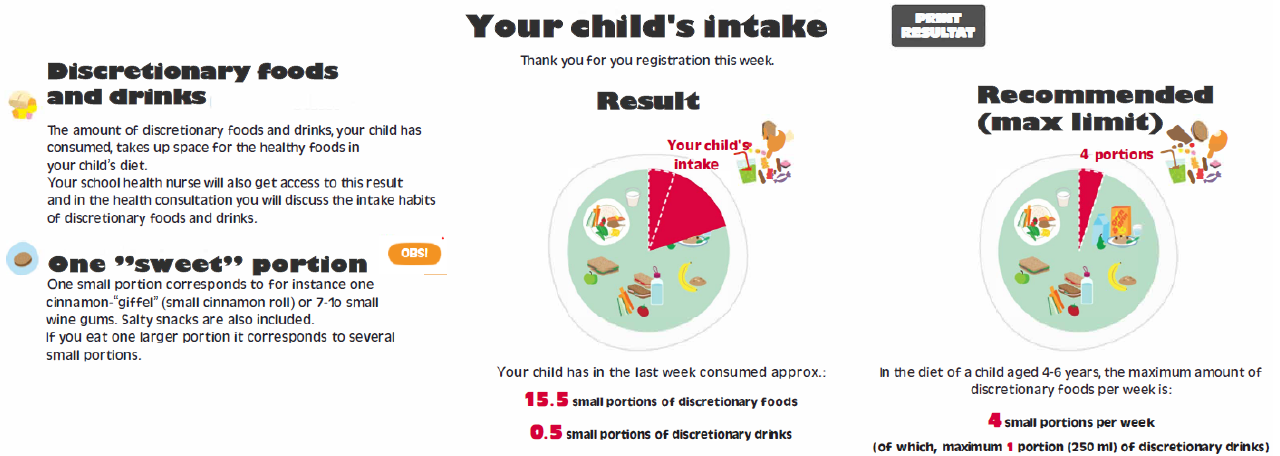
Figure 2. The output from the sugar-rich food screener displaying, as an example, the intake of, in all, 16 small portions (15.5 small portions of discretionary foods and 0.5 portions of discretionary drinks) in the left pie chart and the recommended weekly maximum number of small portions (four small portions) in the right. To the left is the definition of portions. In the original output, the text is in Danish but is translated to English here for better comprehension.